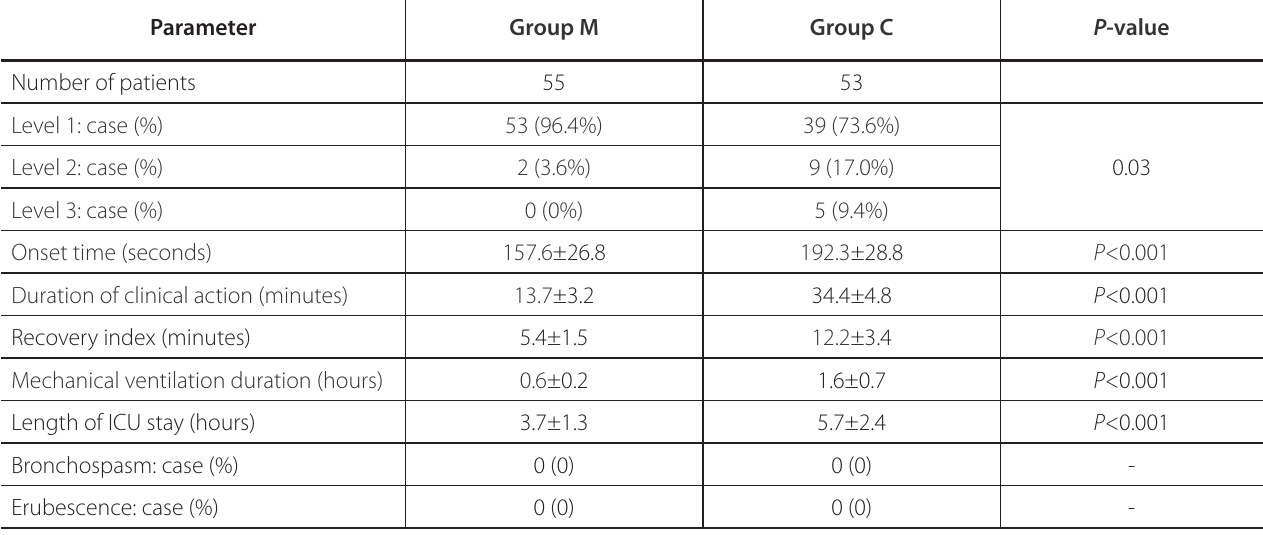
Table 3 . Comparison of intubation conditions, effect of muscle relaxation, and postoperative data and adverse reactions of the two